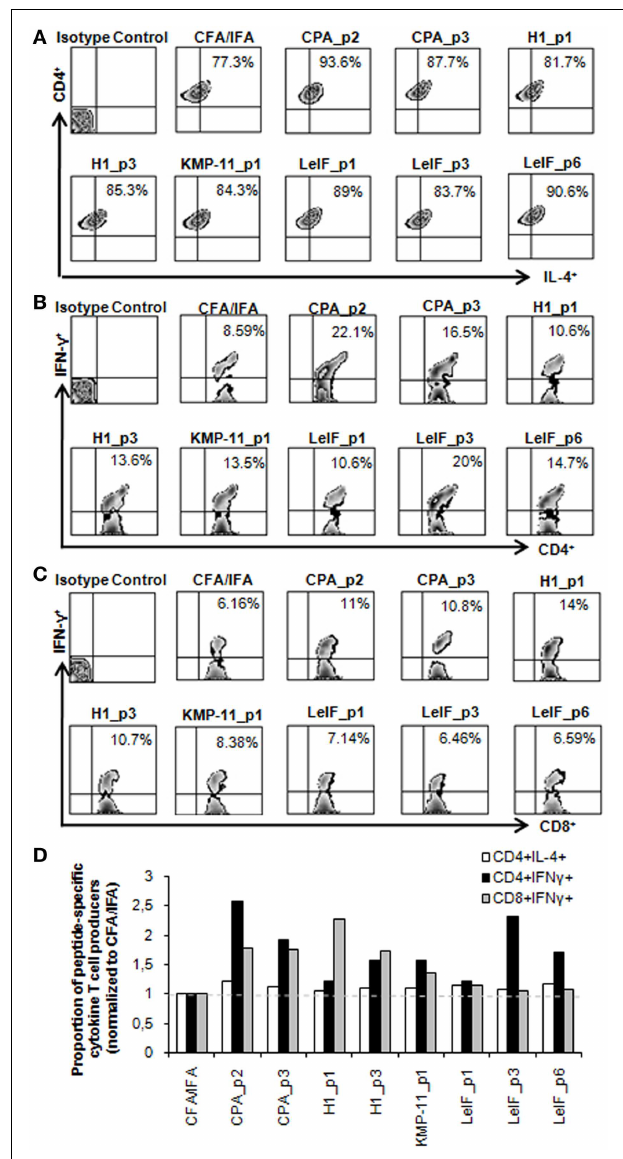
FIGURE 2 | Multi-epitope peptide-specific cytokine production by CD4 + and CD8 + T cells . Spleen cells from BALB/c mice ( n = 5/group) immunized either with individual peptide emulsified in CFA/IFA or PBS alone, were re-stimulated in vitro with the respective peptide (10 µ g/ml) for 48h, and analyzed for CD4 + and CD8 + T cells producing IL-4 and IFN- γ . (A–C) Representative FACS plots of intracellular staining used to define IL-4- and IFN- γ -expressing CD4 + and CD8 + T cells in spleens derived from immunized mice.Values represent the percentages of (A) IL-4 + cells among CD4 + T cells and (B,C) IFN- γ + cells among CD4 + and CD8 + T cell populations. (D) Quantification of IL-4 and IFN- γ producingT cells in immunized mice. All data were normalized to CFA/IFA control group. Each bar represents the mean proportion of IL-4- and IFN- γ -producing CD4 + and CD8 + T cells induced by the respective peptide.